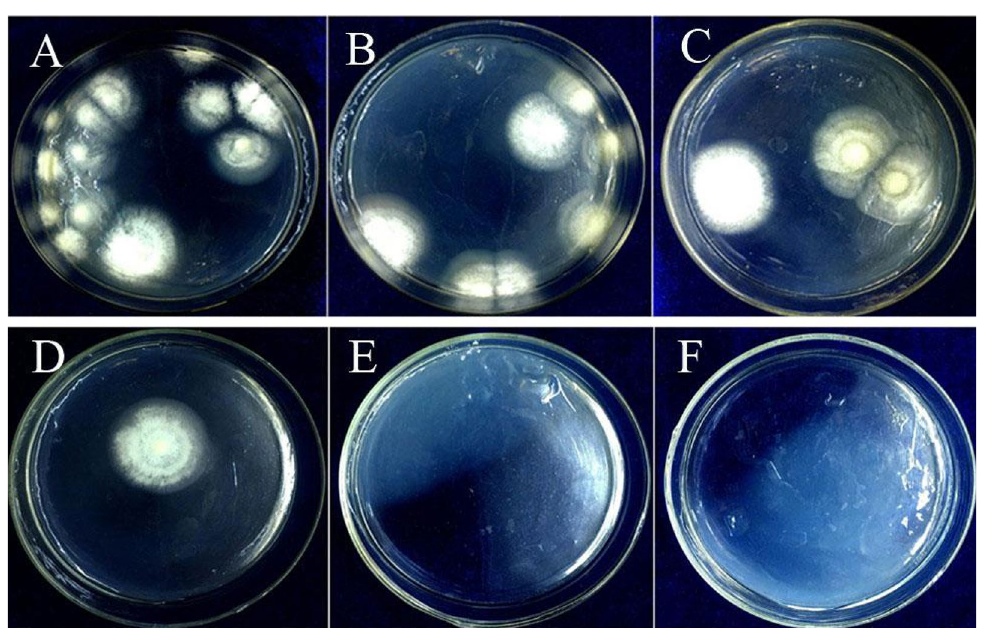
Figure 2. On the plate culture media, the comparison of the spore germination and colony growth of B. bassiana treated with the epidermis mucus of the earthworm E. foetida in different concentrations. ( A ): Control group, in which, before inoculation, the B. bassiana spores were not treated with the earthworm epidermis mucus. ( B–F ): Treatment groups, in which, before inoculation, the B. bassiana spores were treated with the earthworm epidermis mucus in the concentrations of 1.25 mg/mL ( B ), 2.50 mg/mL ( C ), 5.00 mg/mL ( D ), 10.00 mg/mL ( E ), and 20.00 mg/mL ( F ),